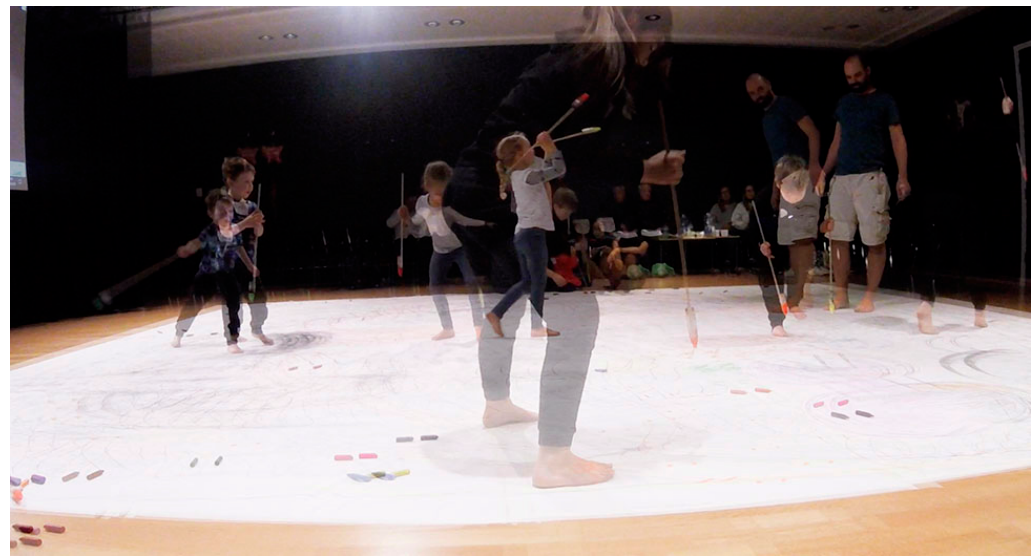
Figure 3. Collective mark-making #2: Group of children and one adult playing with the markers-on-the-stick. Play relations are not based on filiation but on transversal connections.